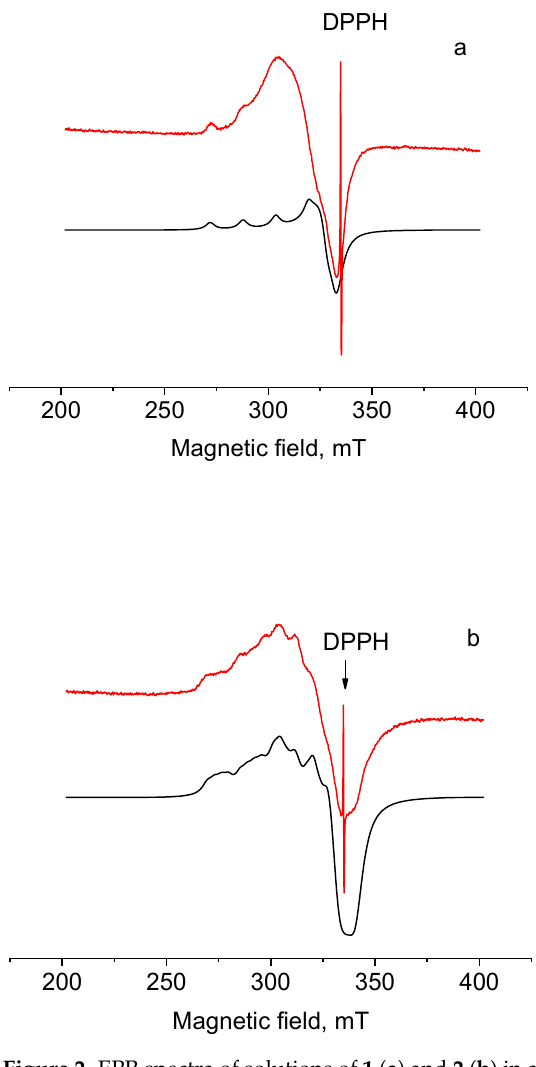
Figure 2. EPR spectra of solutions of 1 ( a ) and 2 ( b ) in acetonitrile at 77 K. Red—experimental spectra, black—simulated spectra.